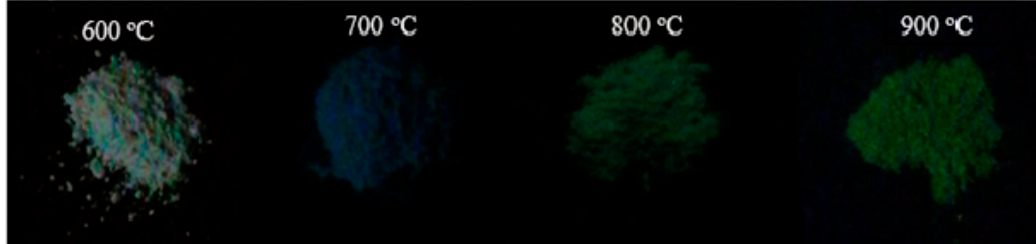
Figure 6. Photoluminescence (PL) spectra of 55ZnO–5B 2 O 3 –40SLS sample sintered at various heat-treatment temperatures.